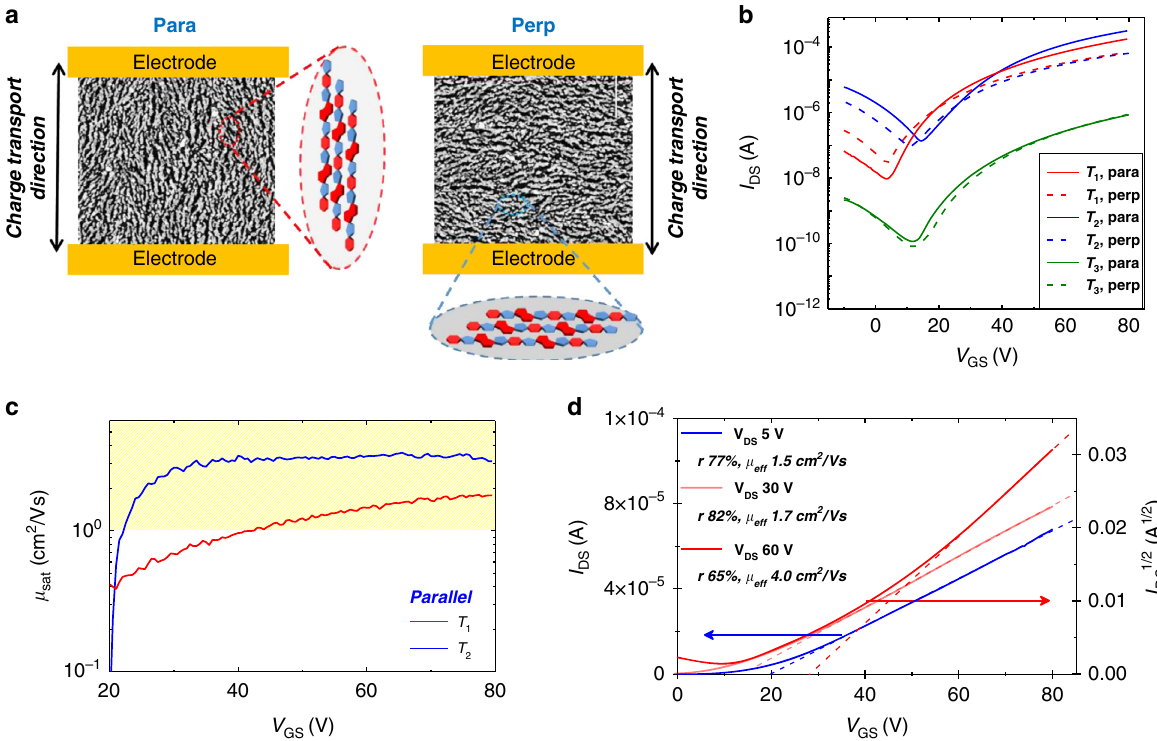
Fig. 6 Electrical data of FETs. FET characterization of PThDPPThF4. a Sketch of source and drain pattern con fi guration parallel (para) and perdendicular (perp), allowing to probe transport parallel and perpendicular to the chain direction, respectively; b transfer curves ( W = 1000 µ m L = 80 µ m), deposited using off-center spin coating, annealed at T 1 , T 2 and T 3 and probed parallel and perpendicular to chain direction; c saturation mobility values ( µ sat ) vs. V GS plot of fi lms annealed at T 1 , T 2 probed parallel to chain direction; d I DS vs. V GS and I DS 1/2 vs . V GS transfer curves measured at V DS = 5 V, V DS = 30 V, and V = 60 V, for devices annealed at T DS 2 and including an injection interlayer. Current values are recorded parallel to the alignment direction. It is worth noting that μ eff of ≈ 1.5 cm 2 /Vs is obtained already in the linear regime ( V DS = 5 V), as a result of a high reliability factor of ≈ 77%. Such a high r value indicates FET behavior not far from ideality. In the present case the reliability factor is mostly limited by the non-zero threshold voltage. As a con fi rmation, at the onset of the saturation regime ( V DS = 30 V), an r up to ~82% is extracted, due to a reduced threshold voltage of V Th = 14 V. Moreover, a notable µ eff value of ≈ 4 cm 2 /Vs is obtained at V DS = 60 V ( r = 65%, µ sat = 6.1 cm 2 /Vs). FET parameters of curves in d : W = 1000 µ m; L = 100 µ m; C i = 5.7 nF/cm